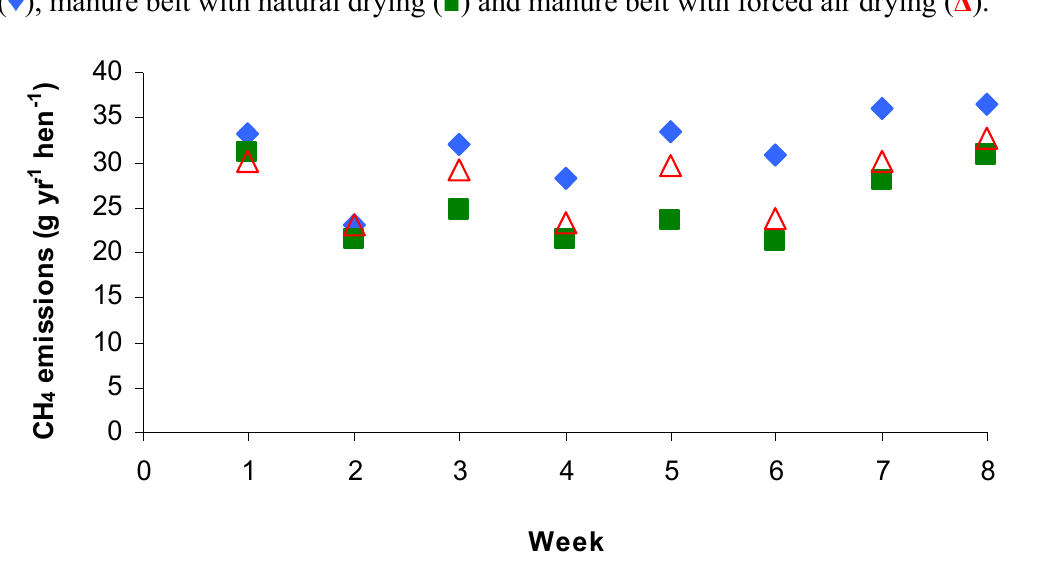
Figure 4. Mean weekly methane emissions from three housing systems: deep liquid